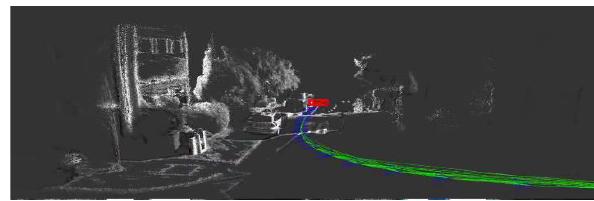
Figure 2. Sample of